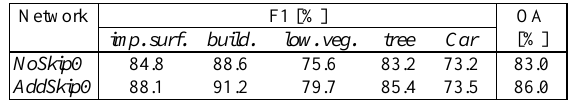
Table 2 . Results of land cover classification using different network variants for Vaihingen ( full reference ).